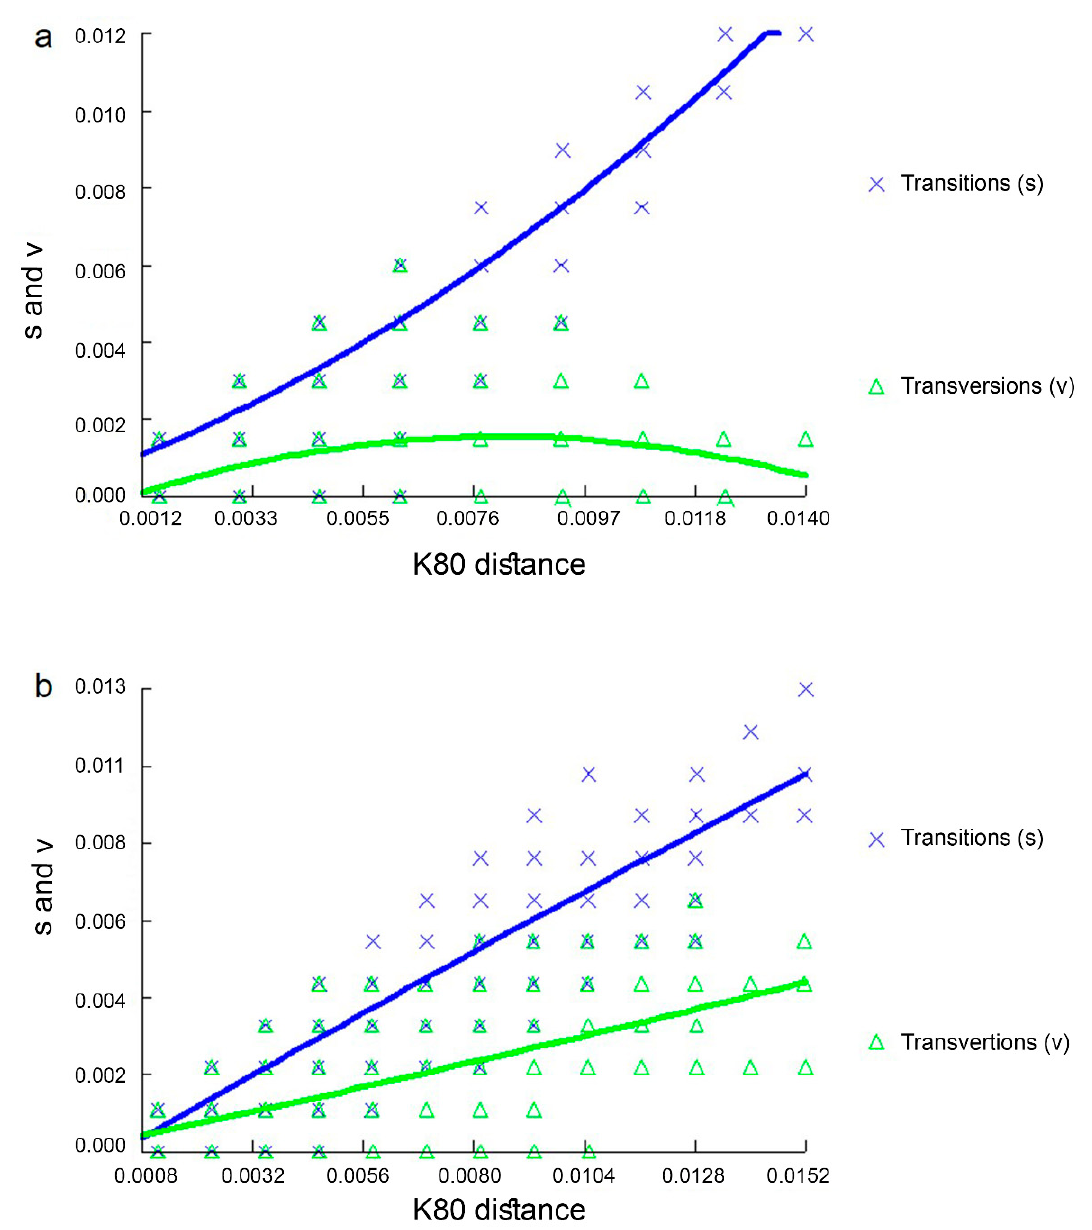
Figure 3. DAMBE7 substitution saturation plots for ( a ) CR1 and ( b ) CR2. Numbers of transitions (s) and transversions (v) are plotted against the K80 distance; lines indicate mean values (thick lines) and standard deviations (fine lines) of s and v.